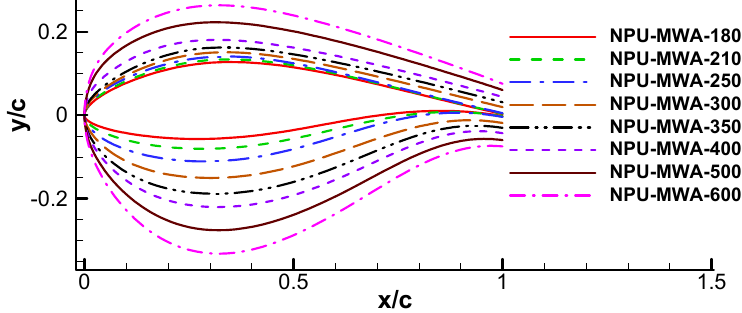
Figure 2. Geometric shape of the NPU-MWA wind turbine airfoil family.